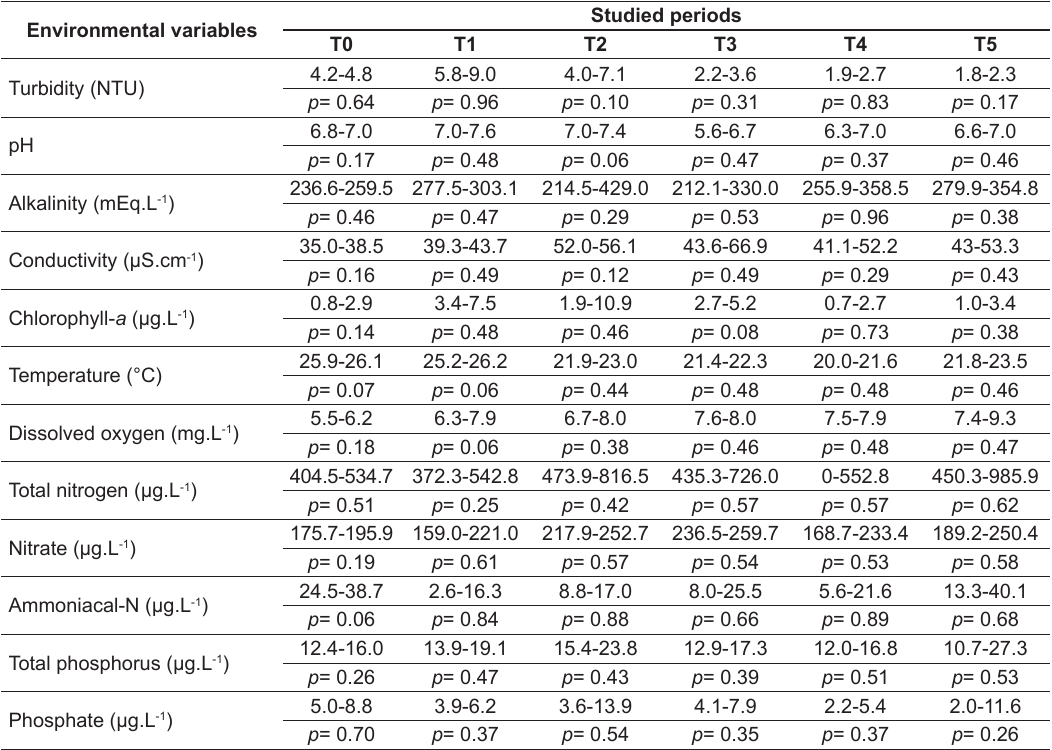
Table 1. Minimum, maximum values and significance of the environmental variables recorded for each studied periods (T0 = before cage installation, T1 = 15 days, T2 = 30 days, T3 = 60 days, T4 = 90 days, and T5 = 120 days after cages installation) - Corvo River, Rosana reservoir (SP/PR).